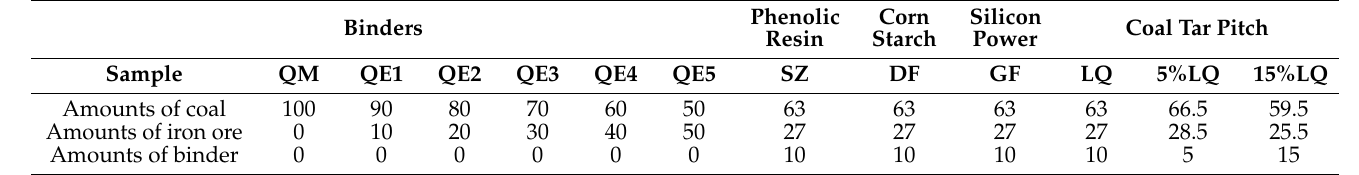
Table 4. Raw material ratios for the preparation of different kinds of ferro-cokes